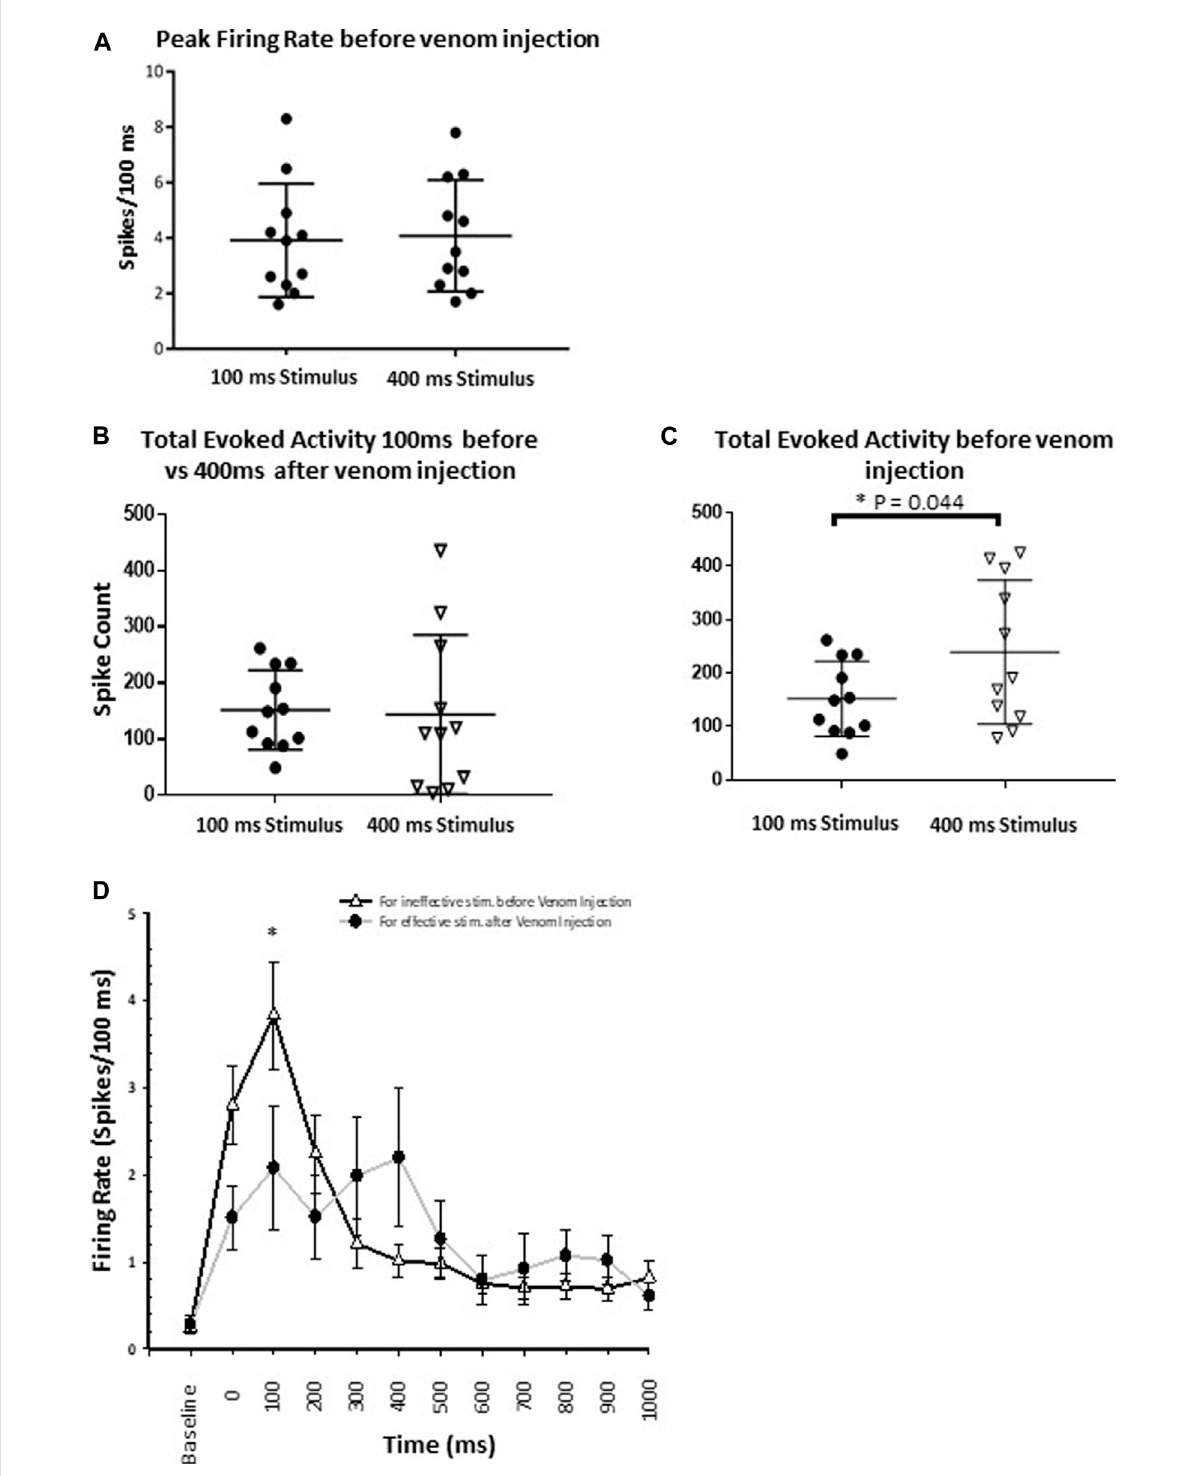
FIGURE 8 WaspvenomcausesthedesensitizationofnociceptiveresponseinCX. (A) ComparisonofPeak fi ringratebeforethevenominjectionshowsnodifference inpeak fi ringrateforeithertypeofstimuli(Ineffectiveandeffective).Thisshowsthatnoadditionalneuronalprocessesarerecruitedbyeffectivestimuli. (B) For ineffectivestimuli(100 ms)totalevokedactivitybeforethevenominjectionremainstobesimilartothetotalevokedactivityforeffectivestimulus(400 ms)after the venom injection. (C) Comparison of total evoked activity before the venom injection for either type of stimuli. Effective stimuli (400 ms laser stimuli) triggers signi fi cantly higher activity inthe CX. (D) Peri-stimulus time histograms (PSTH)for ineffective 100 ms laser stimulus before the venom injection (black line with white triangle) and for effective 400 ms laser stimulus after venom injection (grey line with black dot). PSTH for ineffective stimuli before the venom injectionissimilartothePSTHforeffectivestimuliaftervenominjection.WaspvenomincreasesthethresholdfornociceptiveresponseinCX.pointsrepresent means ± SEM, signi fi cance is indicated with an asterisk (*: p ≤ 0.05; **: p ≤ 0.01; ***: p ≤ 0.001, n = 11 units from 7